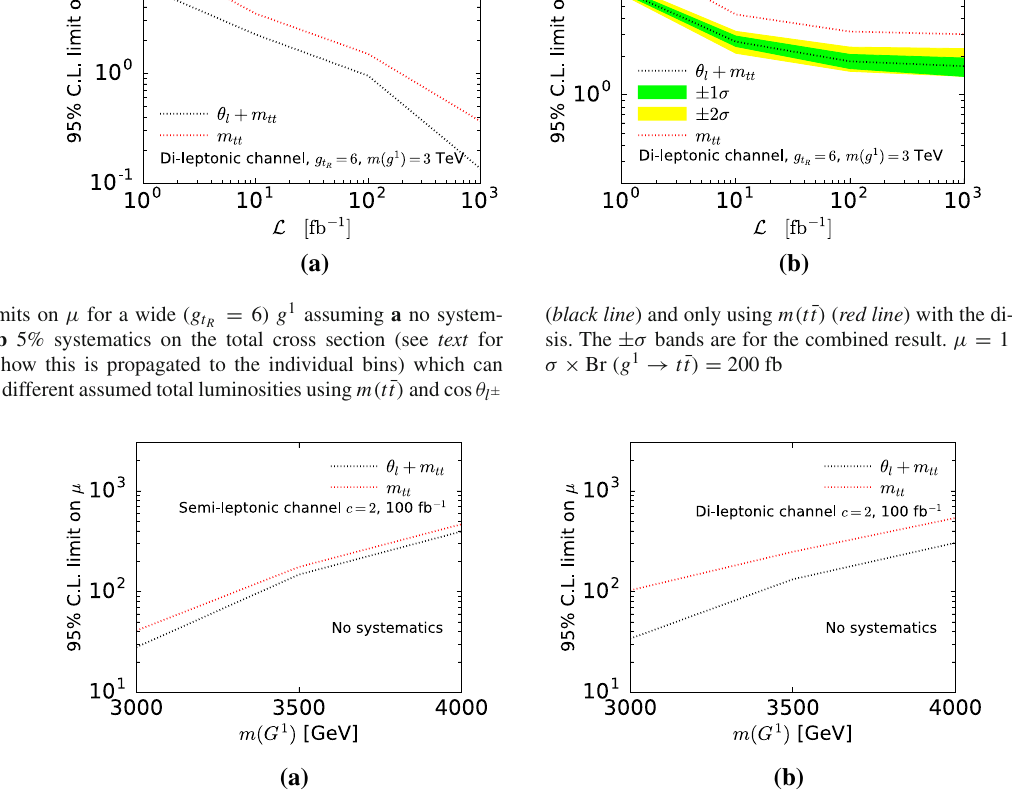
( black line ) and only using m ( t ¯ t ) ( red line ). The ± σ bands are for the